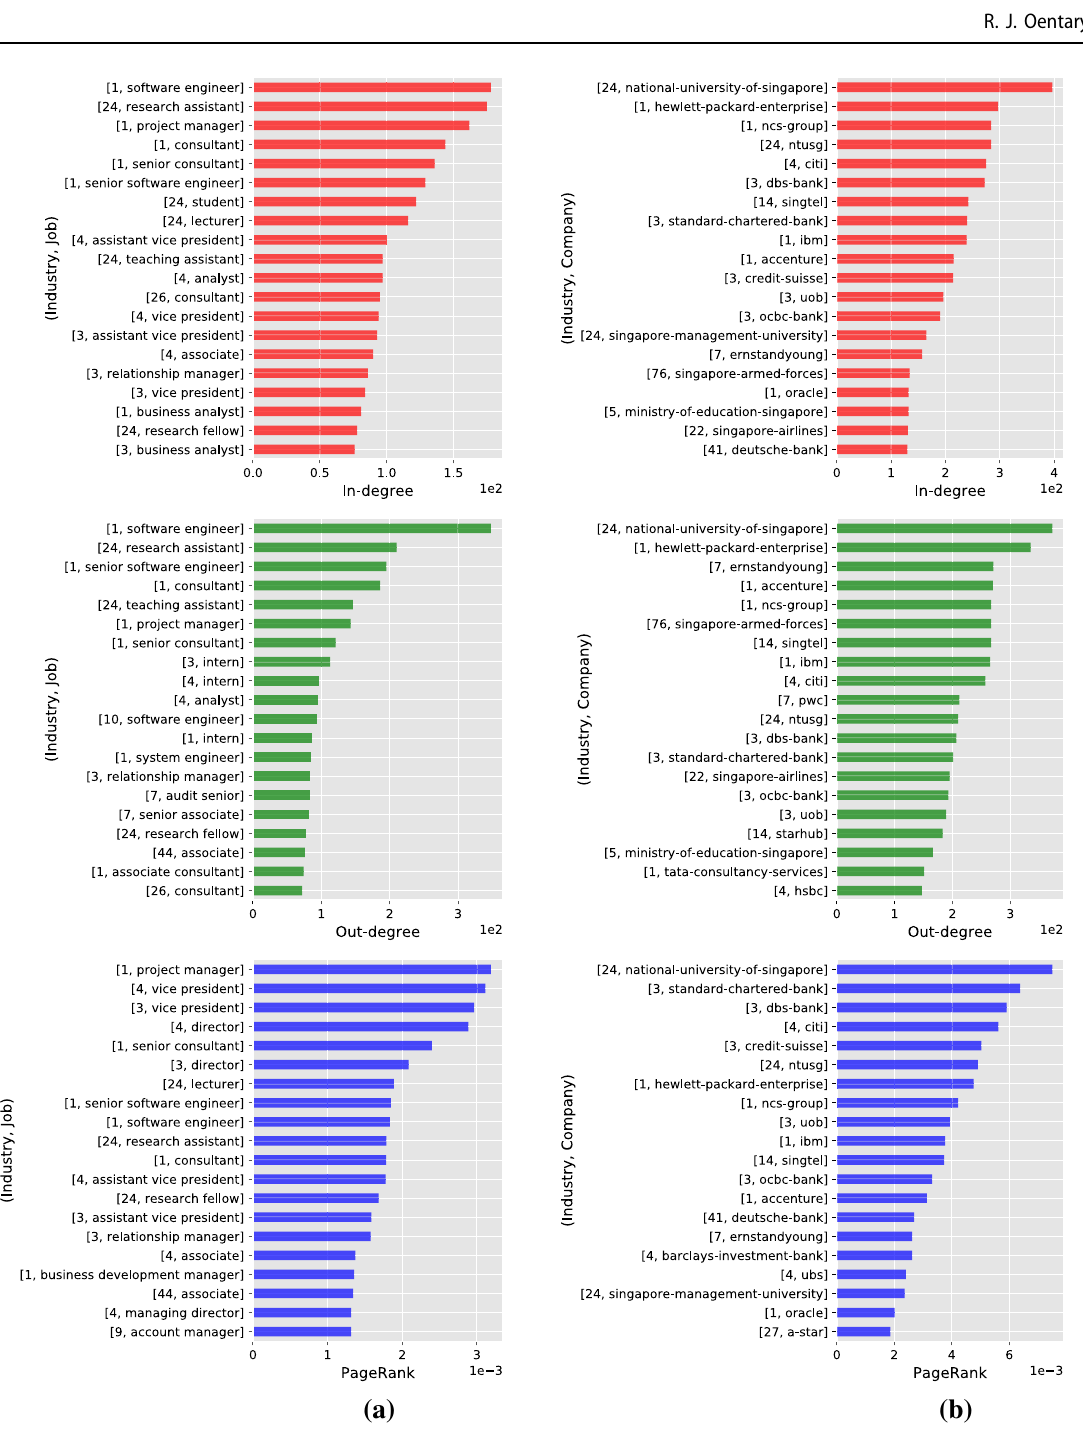
Fig. 14 Centrality of top jobs and companies in Singapore. a Top jobs in Singapore. b Top companies in